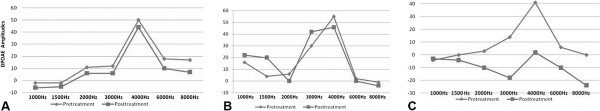
Graph demonstrating DPOAE amplitudes before and after terbinafine solution (A), saline solution (B) and gentamicin solution (C). There were no statistically significant differences in DPOAE measurements for terbinafine solution (p > 0.05). There were no statistically significant differences in DPOAE measurements for saline solution (p > 0.05). There were statistically significant differences at 3000, 4000, 6000, and 8000 Hz of DPOAE values for gentamicin solution (p < 0.05).